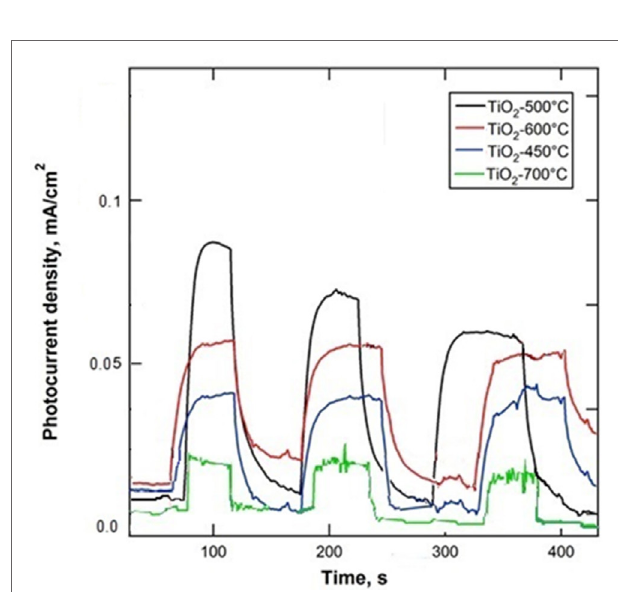
FigUre 10 | current density (j) – potential curve of in simulated aM 1.5 illumination for TiO 2 nanofibers annealed at 450, 500, 600, and 700°c .